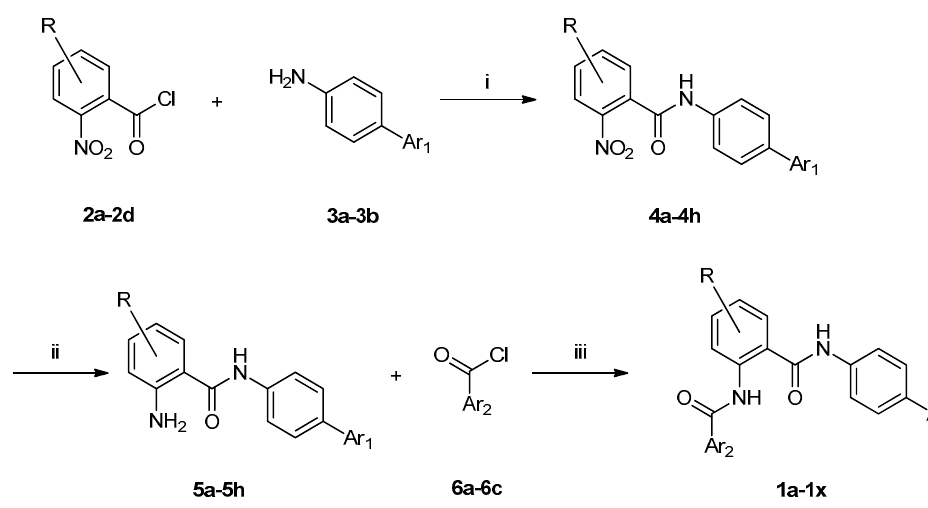
Table 1. The structures of the target compounds 1a – 1x and their biological activity